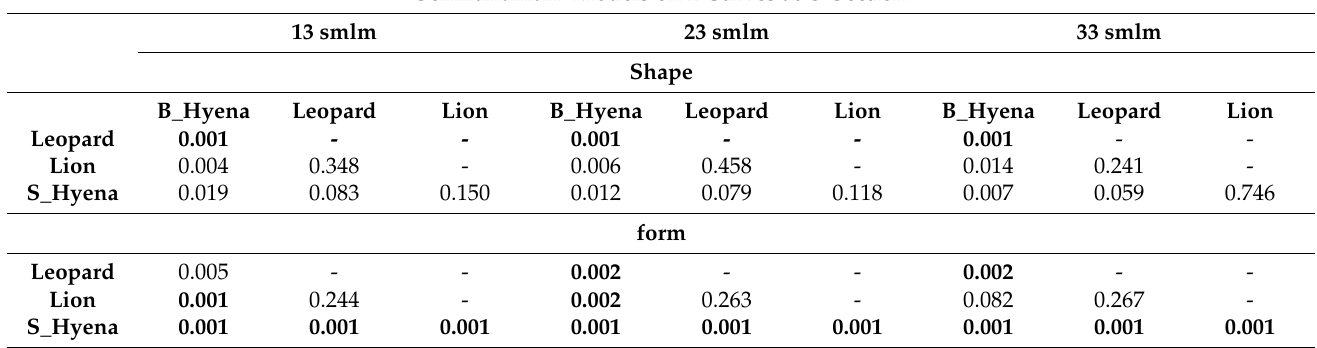
Table 6. MANOVA p -values obtained on the 13, 23, and 33 semilandmark (smlm) models on two curves used to describe the most conspicuous U cross-sections of the carnivore scores. Statistical significance ( p < 0.003) is marked in